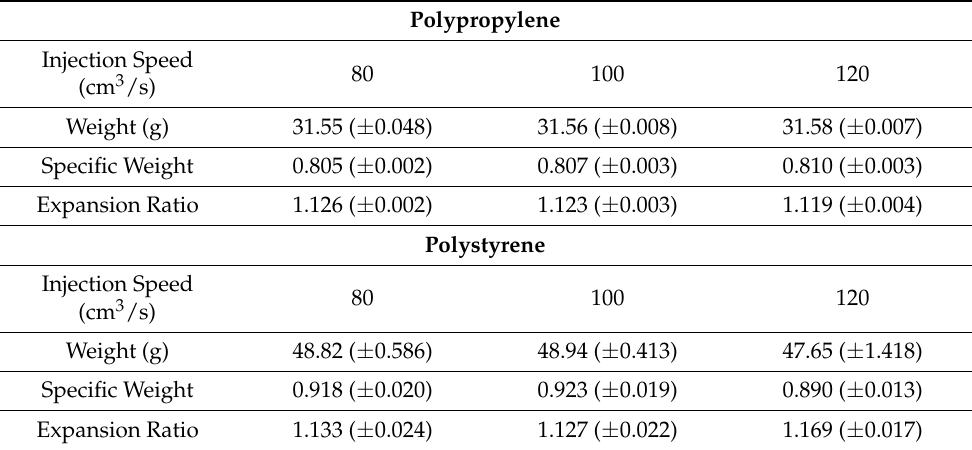
Table 4. Macroscopic effects of injection speed on weight, specific weight, and expansion